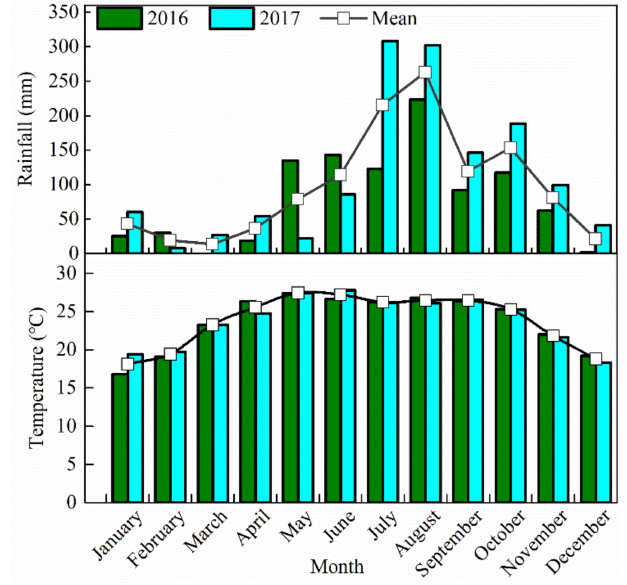
Figure 1. Rainfall and temperature in experimental site Jinghong from 2016 to